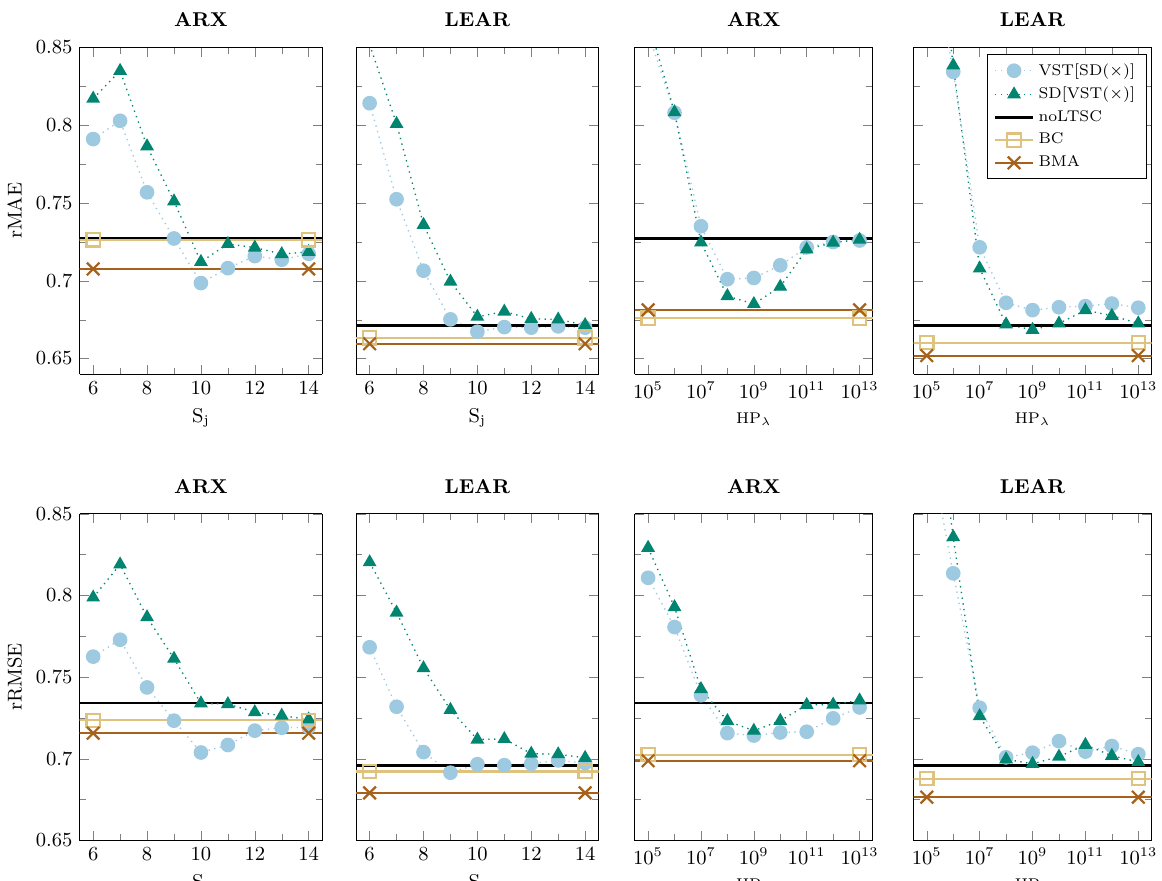
Figure 6. Relative mean absolute errors (rMAE; top row ) and relative root mean squared errors (rRMSE; bottom row ) for individual and combined forecasts obtained for the ARX ( left panels ) and LEAR ( right panels ) models and the PJM dataset. Markers and line styles used are the same as in Figure